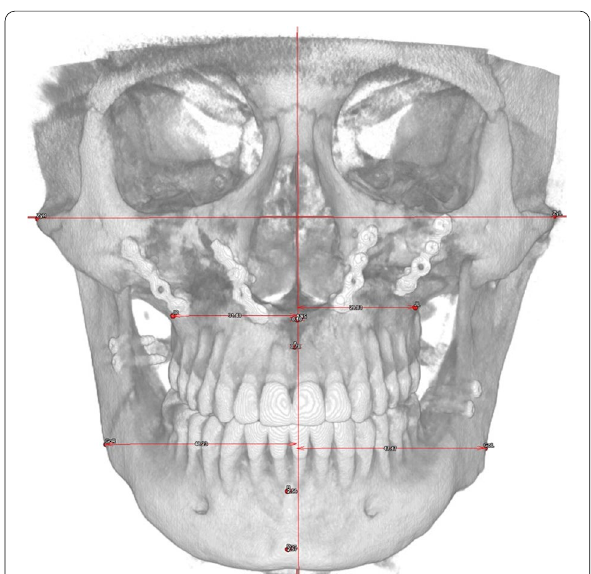
Fig. 4 View of a frontal skeletal analysis in a PostOp